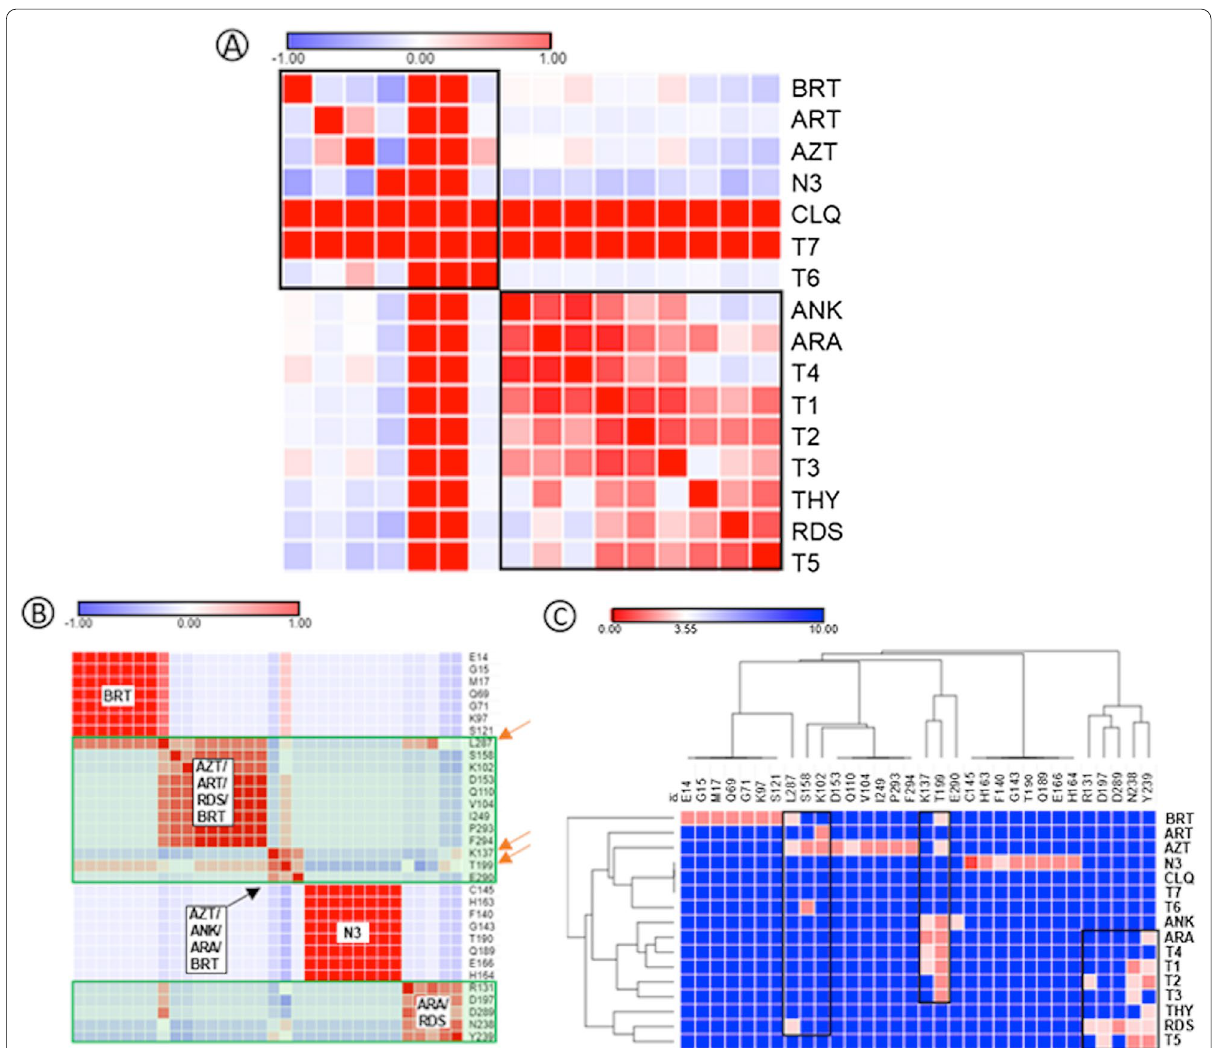
Fig. 4 Heatmap representation of binding between Mpro and ligands. A Pearson’s similarity test for ligands analyzed on this study; B Pearson’s similarity test between Mpro amino acid residues; C interactions between ligands and Mpro residues. AZT (azithromycin); BRT (baricitinib); RDS (remdesivir); ANK (anakinra); CLQ (chloroquine); ART (artemisin); ARA (artemisin acid); THY (thymoquinone). For interpretation, the range varies from 1 (blue) to 1 (red), where red indicates stronger and closer interactions, while blue indicates weak and distant − +